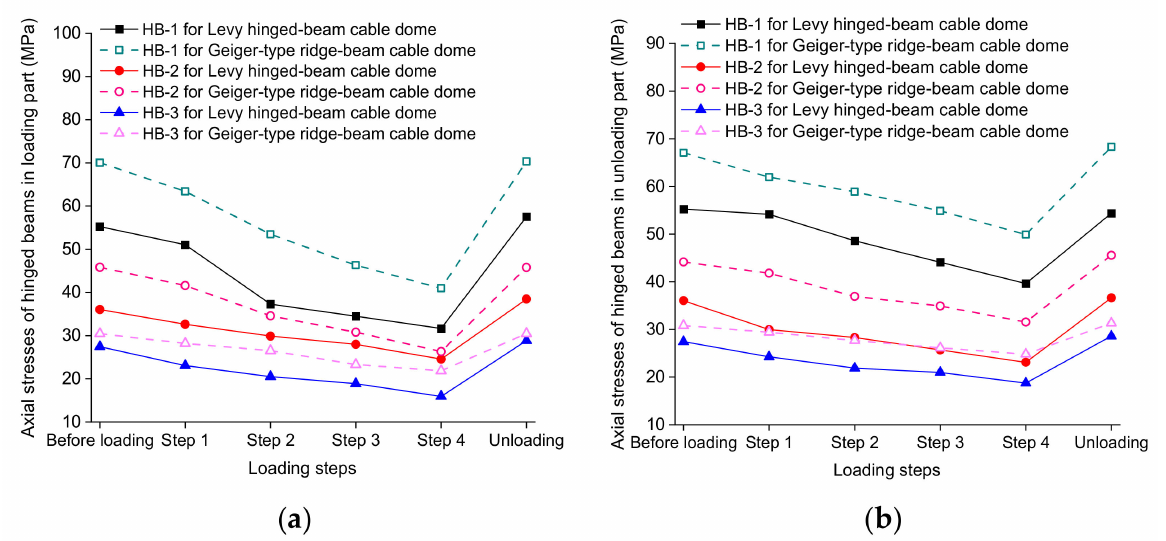
Figure 33. Comparative results of the axial stresses of the HBs. ( a ) Loading part; ( b ) Unloading